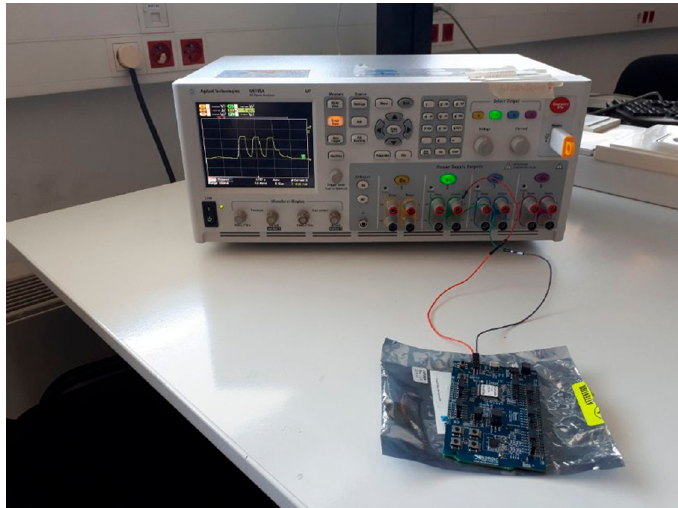
Figure 5. Experimental setup for the current consumption characterization of the nRF51422 PCA10028 board (front) using an Agilent N6705A power analyzer (back).